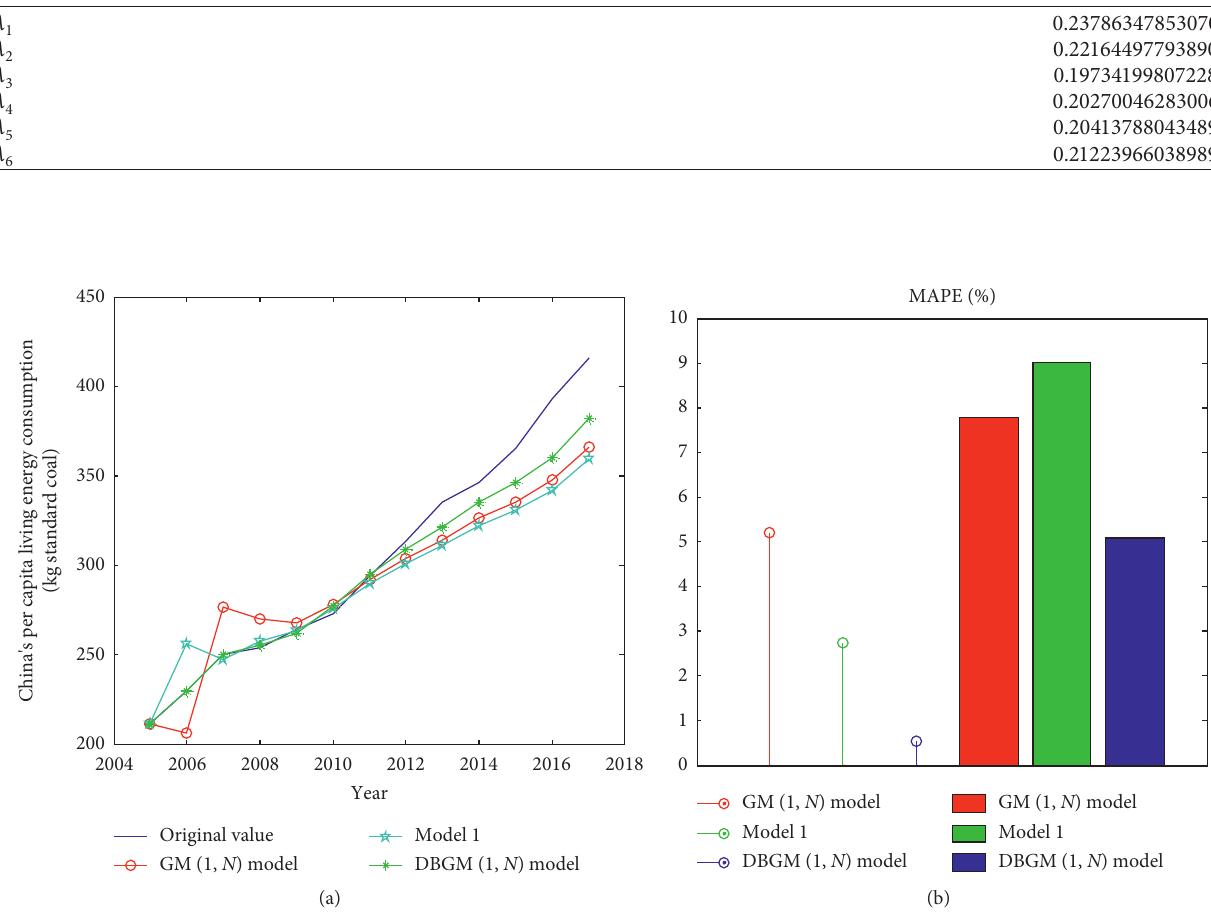
Figure 3: Schematic of the prediction results and MAPEs of the three prediction models (Case